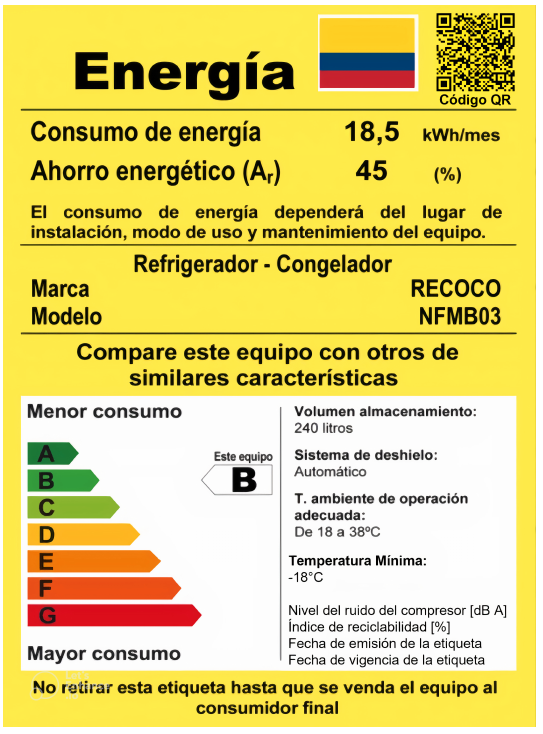
Figure 12. Proposed Energy Label for Domestic Refrigerators in